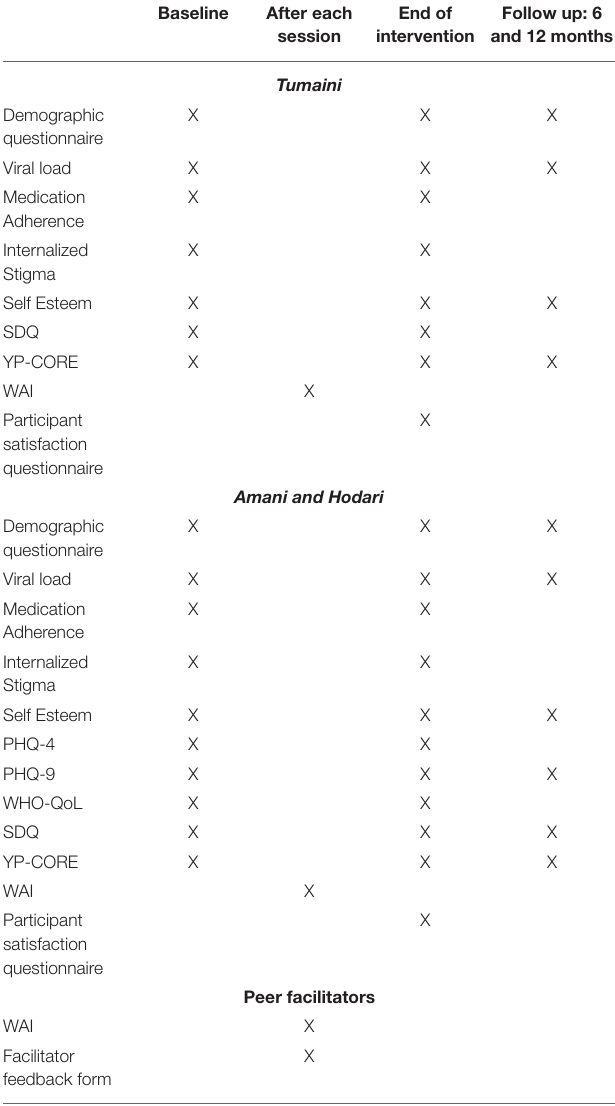
TABLE 3 | Assessment